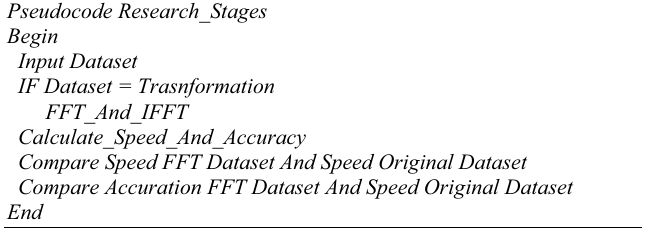
Algorithm 1. Research stages algorithm.